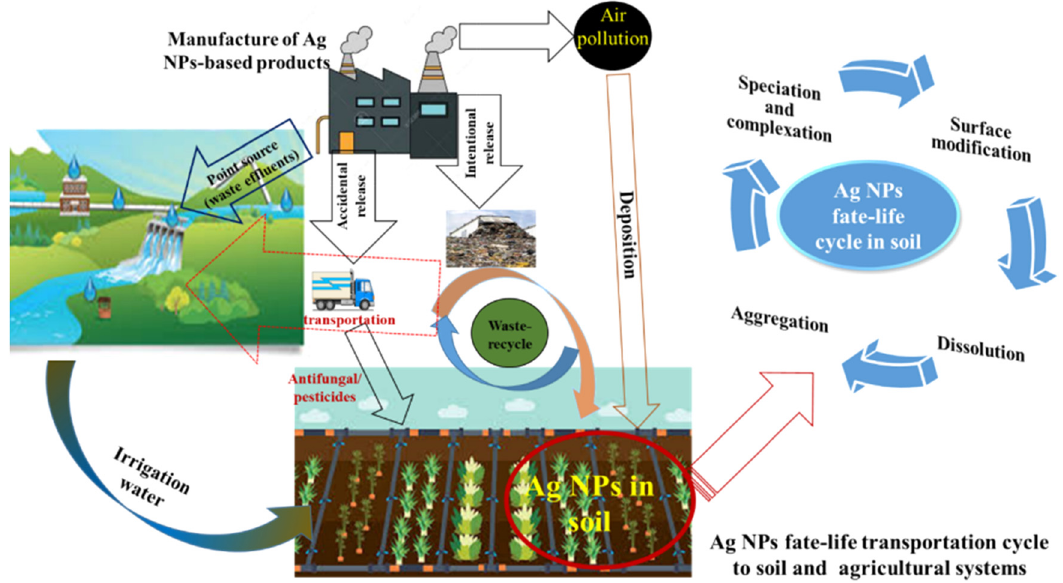
Figure 6: The fate - life cycle of nanoparticles ( e.g. , silver nanoparticles; AgNPs ) from industrialization to soil and agriculture